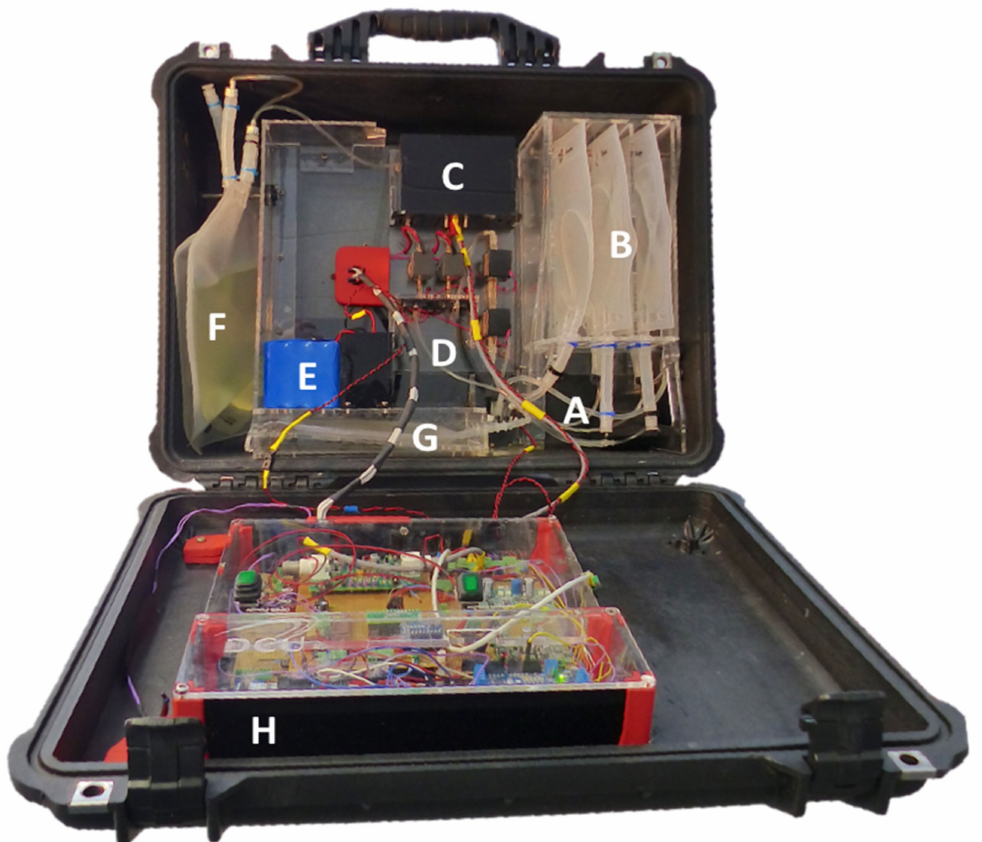
Figure 1. Picture of the autonomous sensing platform. ( A ) Inlet system, ( B ) bags holding sample, high calibration standard, and low calibration standard, ( C ) detection chamber housing the microfluidic chip, LED (375 nm), and photodiode, ( D ) poly(methyl methacrylate) (PMMA) fluidic board, ( E ) battery, ( F ) reagent Bag, ( G ) waste bag and ( H )